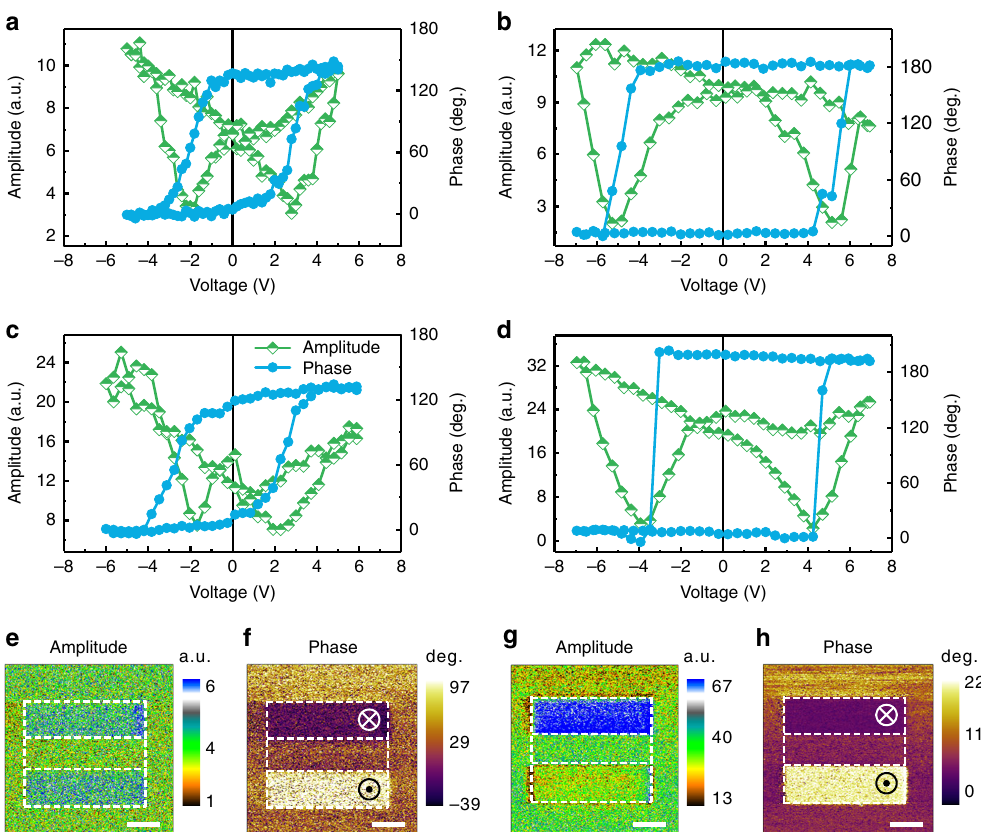
Fig. 3 Ferroelectric switching and stability in 2- and 3-u.c. BFO fi lms. a , b Out-of-plane SS-PFM amplitude (half- fi lled green squares) and phase ( fi lled azure circles) curves for 2-u.c. BFO fi lm measured in air and argon, respectively. c , d Out-of-plane SS-PFM amplitude (half- fi lled green squares) and phase ( fi lled azure circles) curves for 3-u.c. BFO fi lm measured in air and argon, respectively. e , f Out-of-plane PFM amplitude and phase images for 2-u.c. BFO fi lm measured in air after applying + 5 V and − 5 V voltage. g , h Out-of-plane PFM amplitude and phase images for 2-u.c. BFO fi lm measured in argon after applying + 5 V and − 5 V voltage. The scale bar is 1 μ